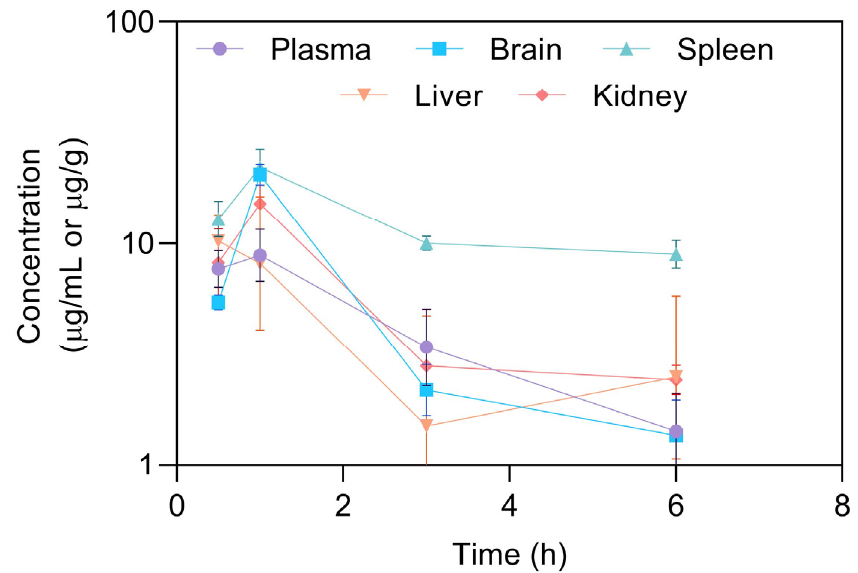
Figure 2. Exploratory pharmacokinetic profiles of celecoxib in solution following an intraperitoneal administration in plasma, brain, spleen, liver, and kidney [19]. Results are presented as average per organ; error bars represent calculated standard deviation (n = 3 per time point, mean ± SD). Table 7. Pharmacokinetic parameters obtained for celecoxib in usNLCs and HNPs Tf , compared to free drug in solution, in plasma, brain, liver, spleen, and kidney [19]. Key—P, plasma; B, brain; L, liver; S, spleen; K, kidney; t max —time to reach maximum concentration; C max —maximum concentration; AUC 0-inf —area under the concentration time-curve from time zero to infinite; AUC 0-last —area under the concentration time-curve from time zero to the previous measurable drug concentration; MRT—mean residence time.